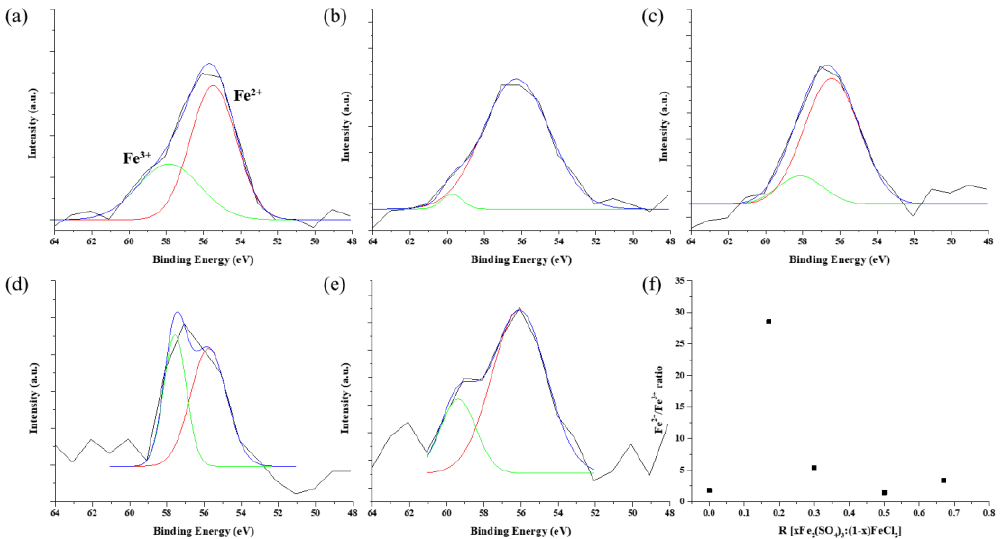
Figure 6. Fe 3p XPS spectra of substrate after removing the CNT forests with di ff erent R values; ( a ) R = 0, ( b ) R = 0.17, ( c ) R = 0.3, ( d ) R = 0.5, ( e ) R = 0.67, and ( f ) Fe 2+ /Fe 3+ ratio.